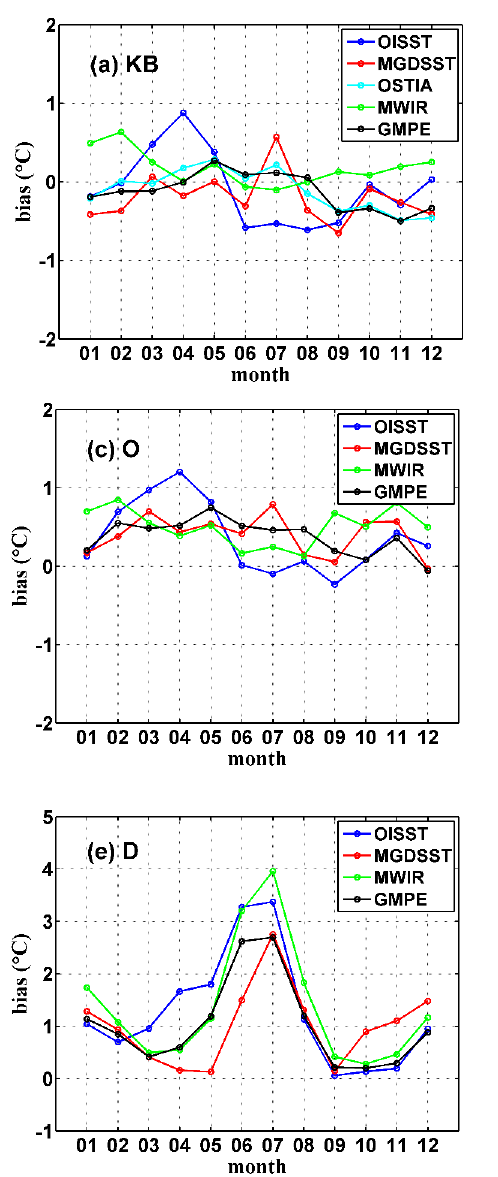
gridded SST data. ( a ) KB, ( b ) SB, ( c ) O, and ( e ) D represent the in situ observations collected at the ocean surface buoy stations. ( d ) NIFS-S and ( f ) NIFS-M represent the in situ CTD observations from the deep stratified region (h > 50 m) and the shallow vertically mixed region (h < 50 m) stations, respectively, along the routine bimonthly observation lines of the research vessels. Note that the vertical ranges in ( e ) and ( f ) are different from those in the other panels.